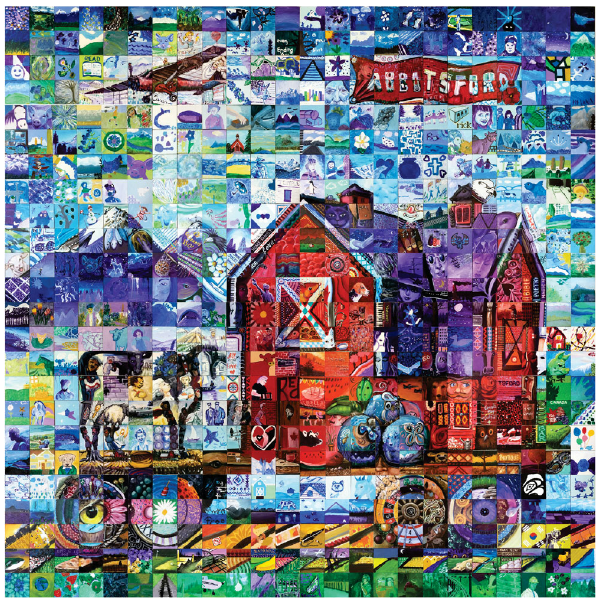
Fig. 2 A discernible image mosaic created by an artist. The presence of visual edges (of the house, cow, airplane, etc.) strongly supports perception of the objects while their textures are more artistic, showing clearly discernible contents, than realistic. Note that the small photos were hand-crafted by the artist, and were not retrieved from a generic photo